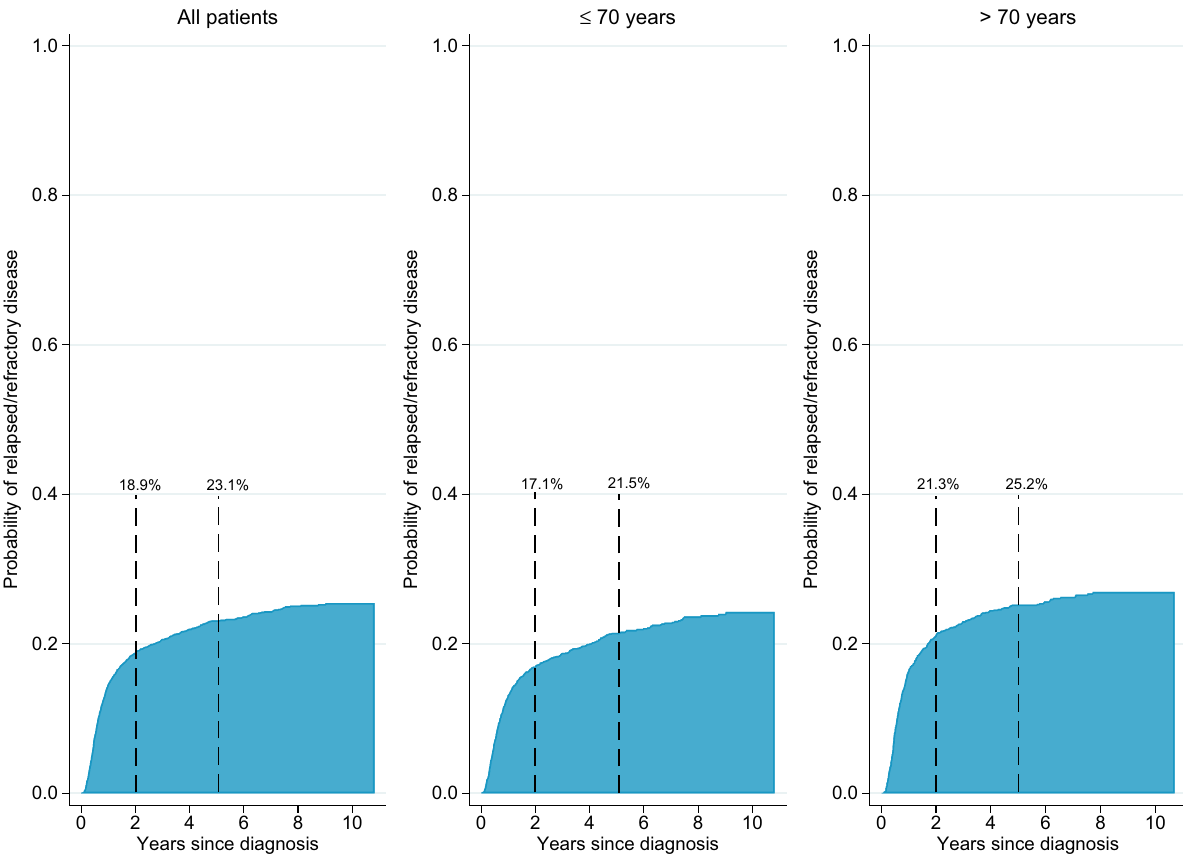
Fig. 2 Incidence of relapsed/refractory disease. Cumulative incidence of relapsed/refractory disease at any site among curatively treated diffuse large B-cell lymphoma (DLBCL) patients overall ( n = 3550, 847 events), and by age at diagnosis (>/ ≤ 70 years) (incidence assessed in the presence of the competing risk of death*). Asterisk indicates Not